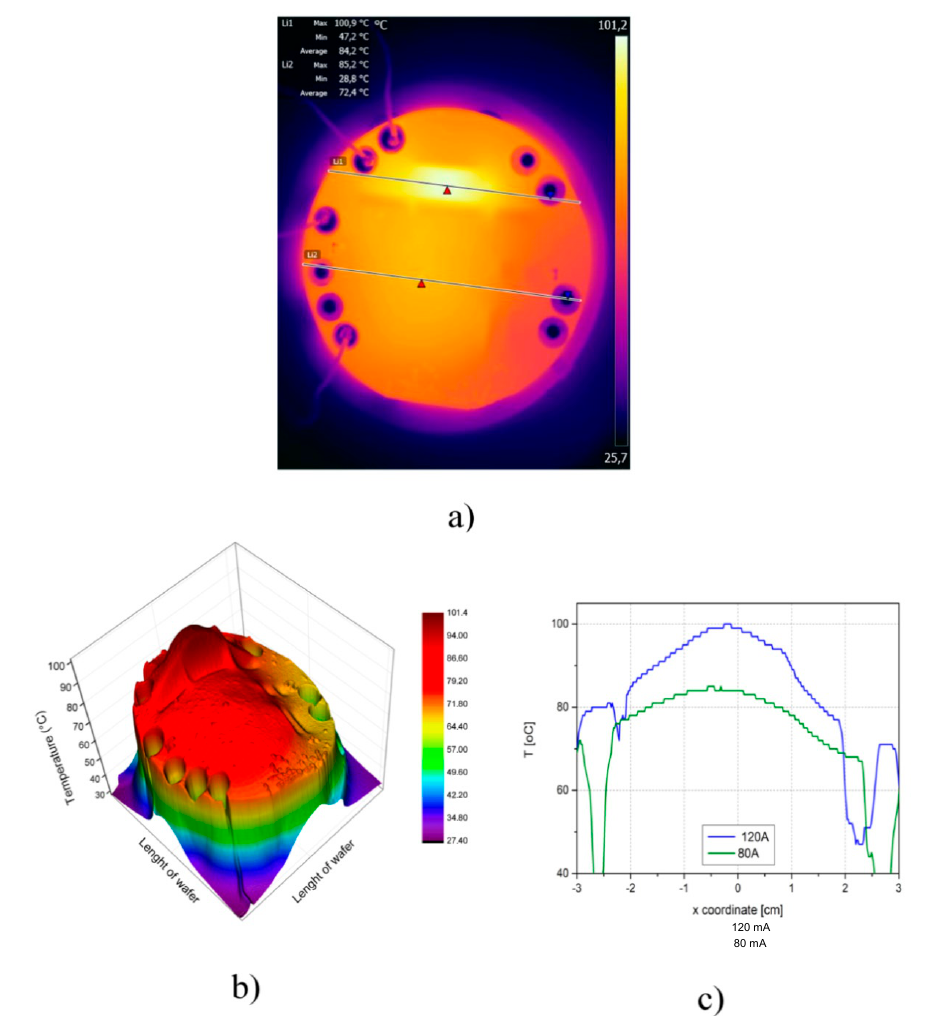
Figure 6. Time evolution of temperature for I H2 = 80 mA and I H1 = 120 mA during 20 min. Micromachines 2020 , 11 , x